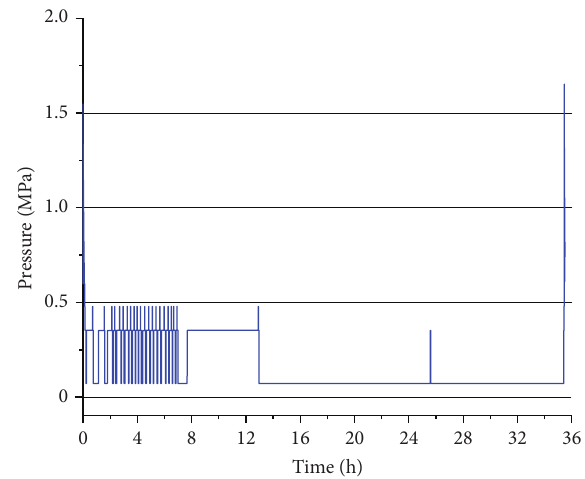
Figure 8: Numerical result of pressure at the end of pipe for the field